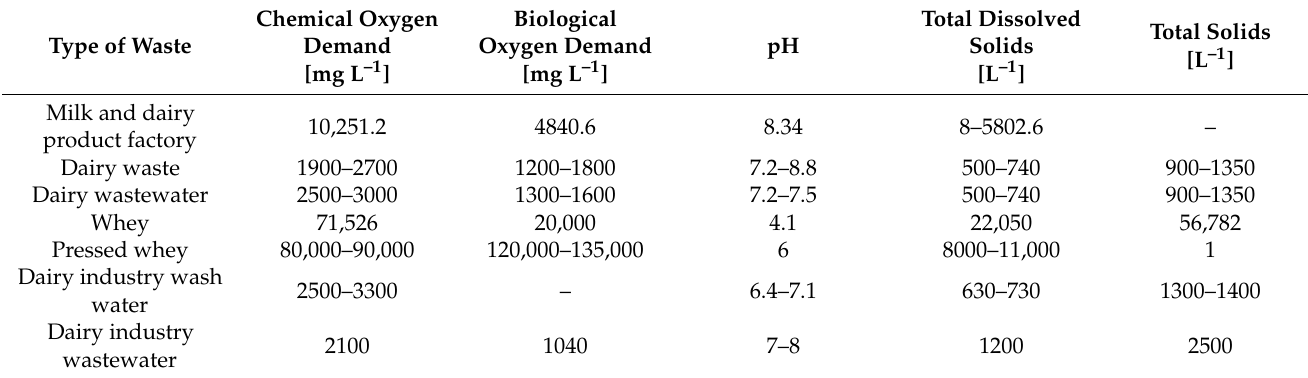
Table 1. Waste loads of dairy industry